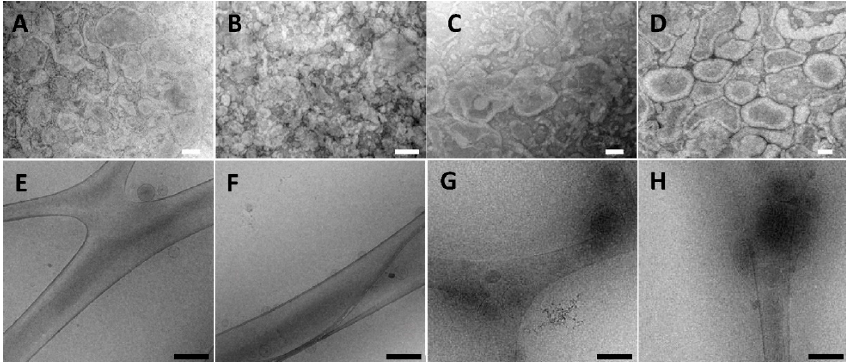
Figure 1. TEM images (upper panel) of three-dimensionally-structured hybrid 59:2 vesicles ( A ), 53:10